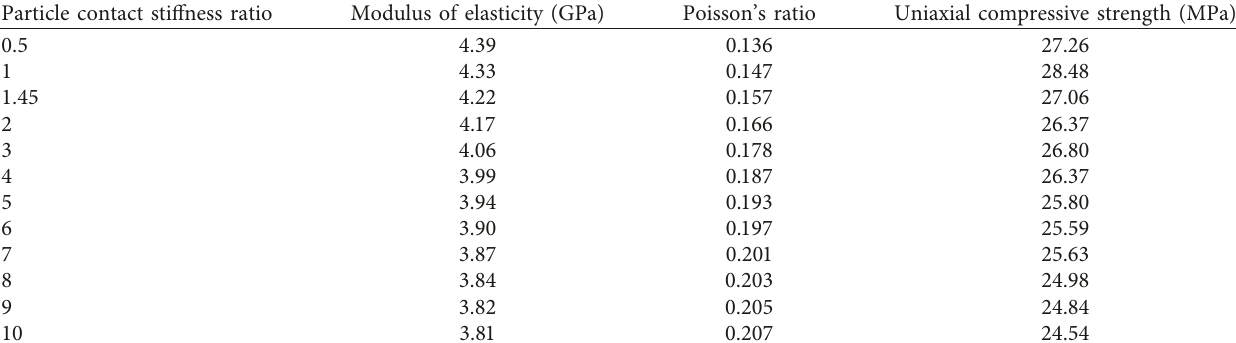
Table 3: The relationship between the particle contact stiffness ratio and macroscopic mechanical properties.